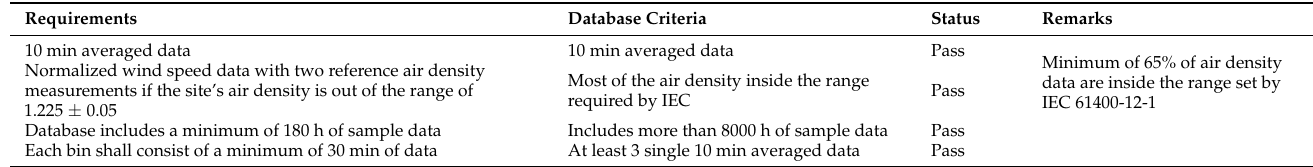
Table 1. IEC 61400-12-1 standard requirements for wind data analysis